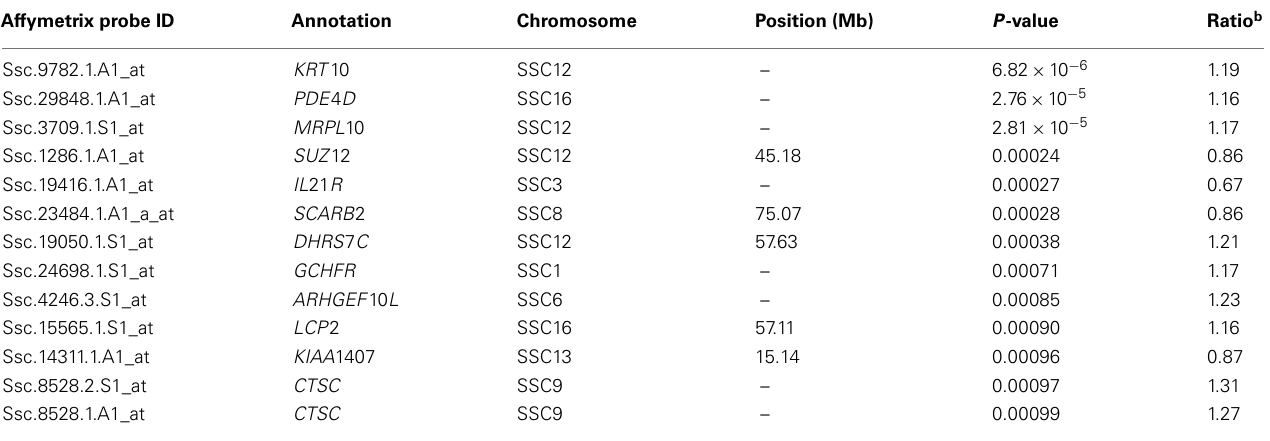
TableA7 | Differentially expressed probes conditional on copy number of ACACA ASGA0066302A allele. Affymetrix probe ID